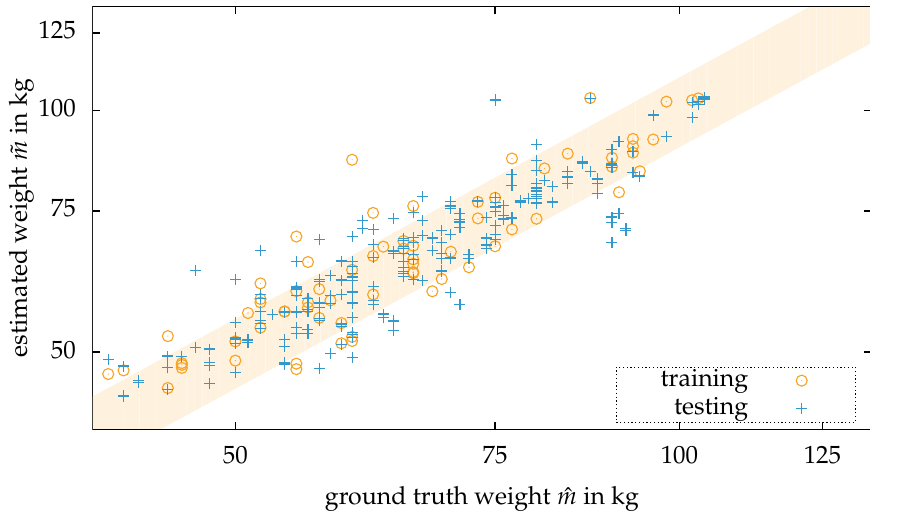
Figure 8. Results of the experiment with people standing in front of the camera based on the here proposed algorithm and the W-300 dataset contributed by Nguyen et al. [26]. The orange area marks the range for the relative error of ± 10